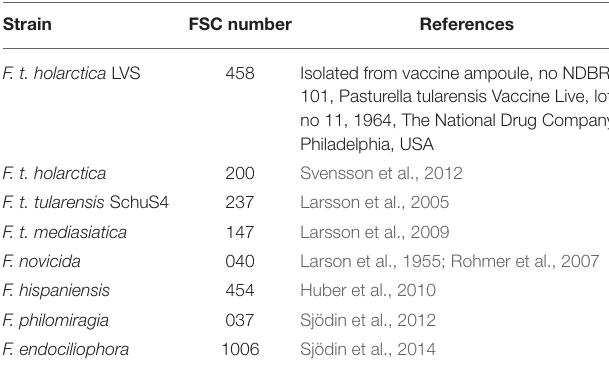
TABLE 1 | Francisella strains included in the